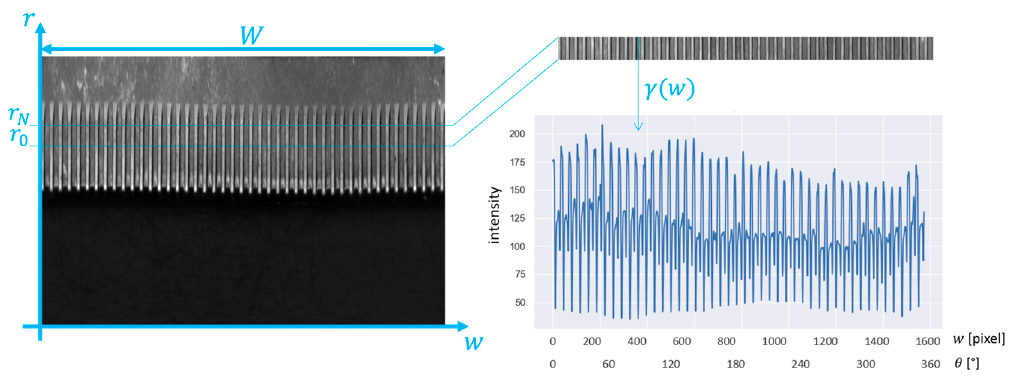
Figure 8. Procedure for the extraction of the stripe from the cartesian picture, and the construction of